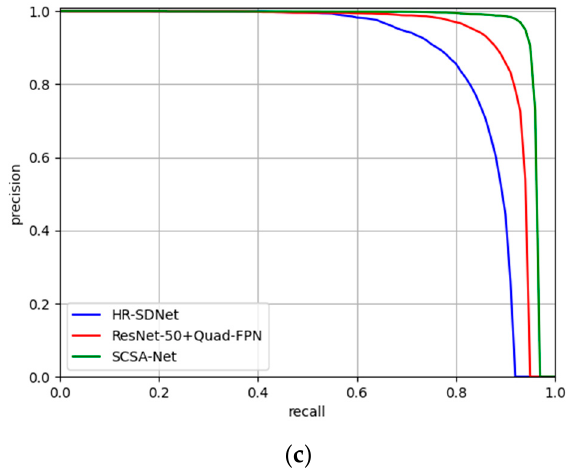
Figure 12. PR curves of different methods. ( a ) PR curves of different methods on SSDD. ( b ) PR curves of different methods on SAR-Ship-Dataset. ( c ) PR curves of different methods on HRSID.